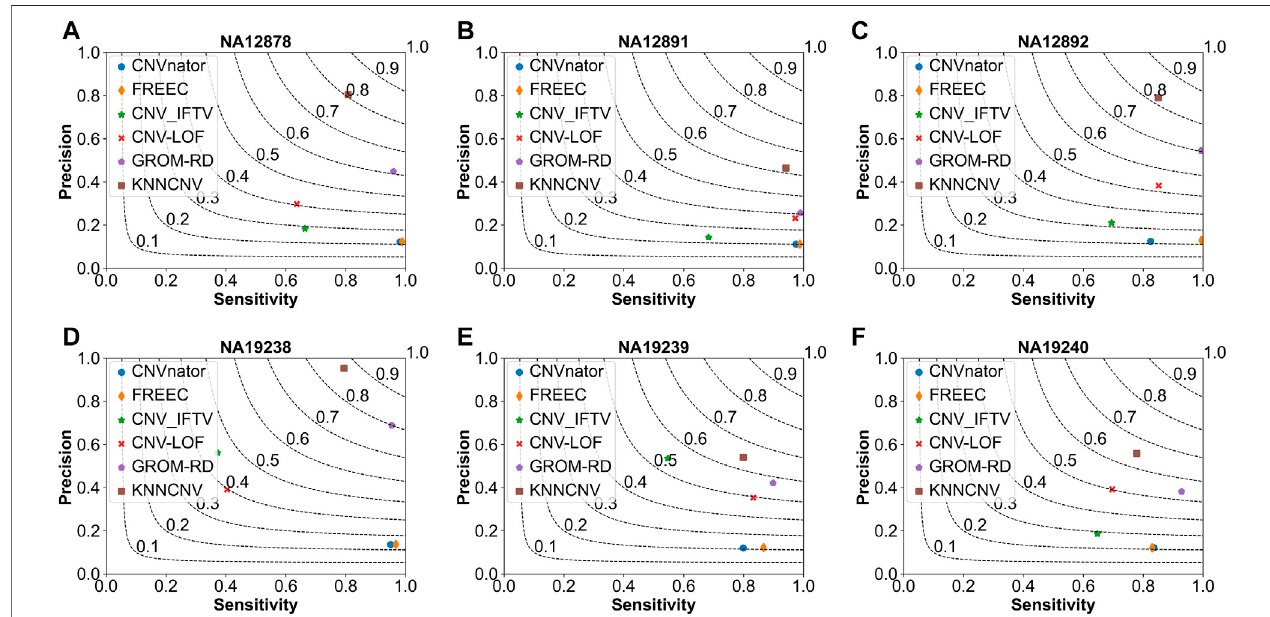
FIGURE5| ComparisonoftheKNNCNVwith fi vepeermethodsontherealdatasetsintermsofprecision,sensitivity,andF1-score.TheF1-scoreisshowninblack dashed lines ranging from 0.1 to 0.9 with an increment of 0.1. (A-F) They show the performance of the above six methods on six real datasets, respectively.